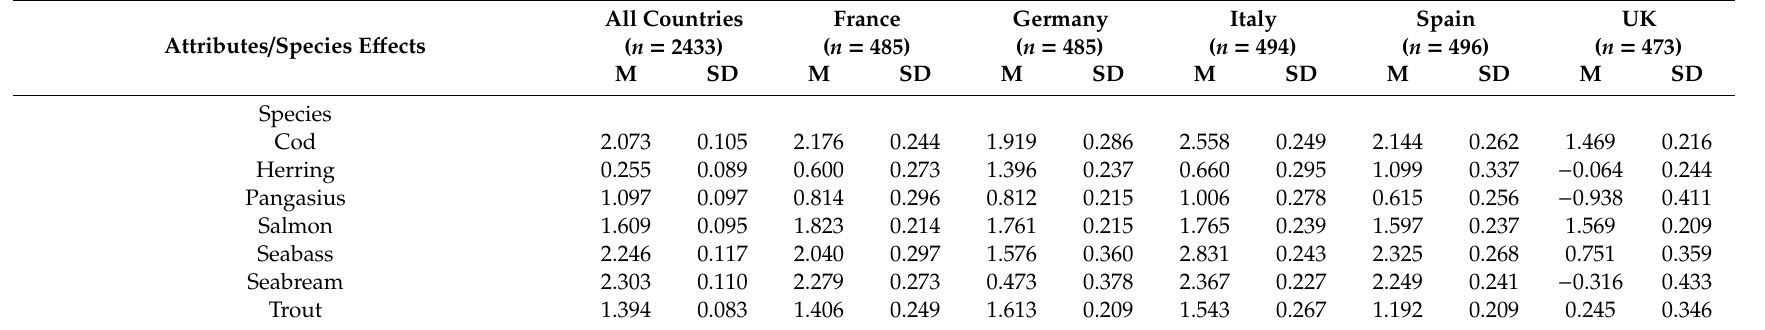
Table A3. β coe ffi cients estimates (M, mean; SD, standard deviation) of the Fish-Species-Specific E ff ect (FSSE) model per